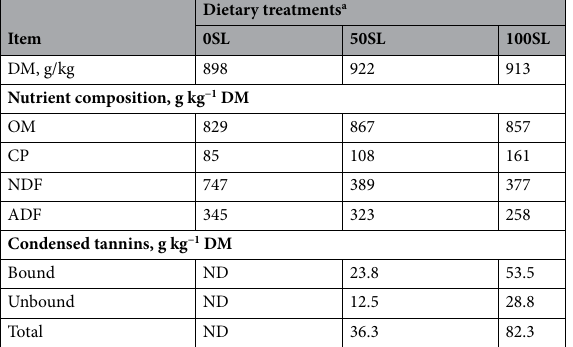
Table 3. Chemical composition (DM basis) of experimental diets containing sericea lespedeza [SL; Lespedeza cuneata (Dum. Cours.) G. Don] hay fed to beef steers donors of excreta (adapted from van Cleef et al. 17 ). ND not detected. a 0SL: 0% inclusion of sericea lespedeza hay (100% bermudagrass); 25SL: 25% inclusion of sericea lespedeza hay; 50SL: 50% inclusion of sericea lespedeza hay; 100SL: 100% inclusion of sericea lespedeza hay (0% bermudagrass